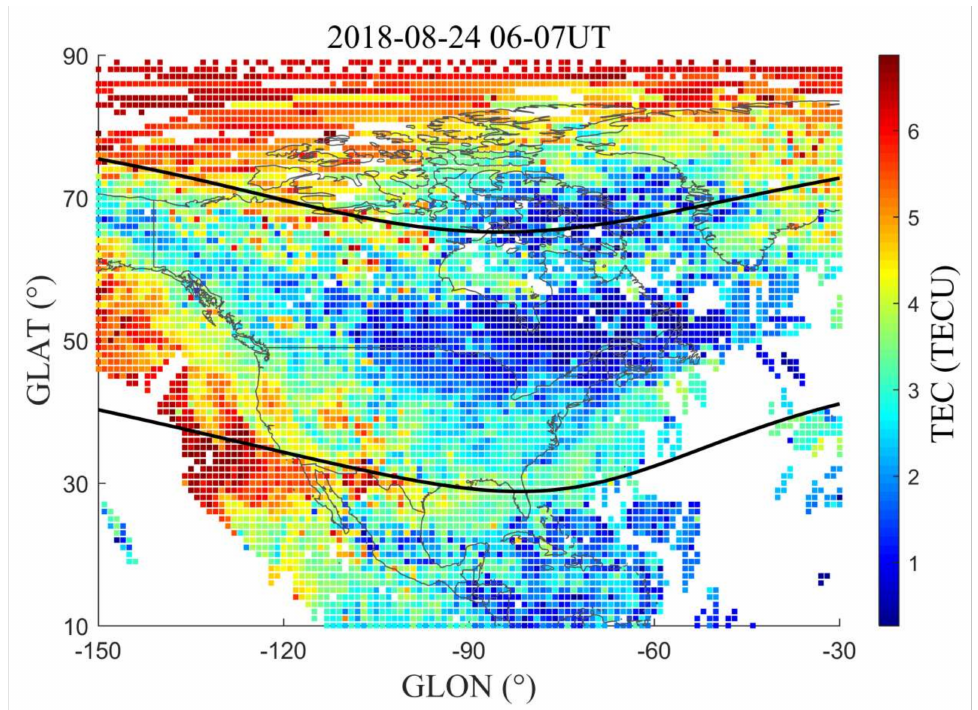
Figure 1. An example of the distribution of TEC data over North America during 06 − 07 UT on 24 August 2018. The upper and lower solid black lines represent 75 ◦ N and 40 ◦ N MLAT, respectively. The SYM-H index, IMF Bz, Kp index, and solar flux index F10.7 data were